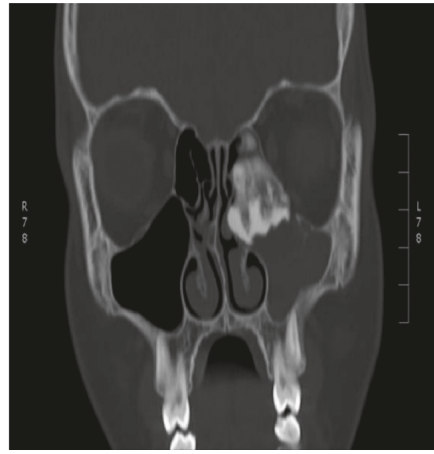
Figure 1: The CT scan of the paranasal sinuses shows a left ethmoid mass.